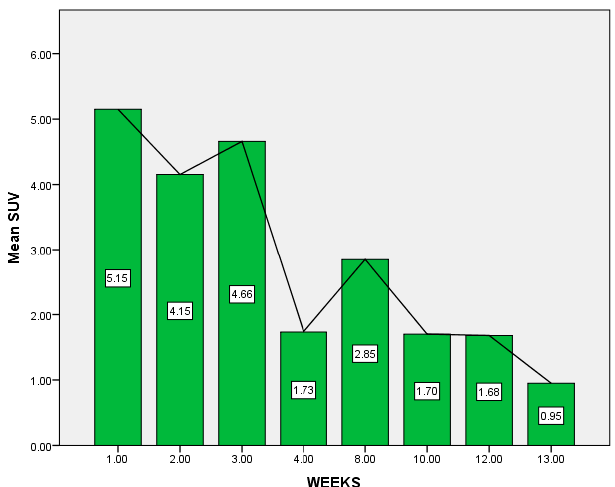
Figure 2. Variation of mean SUVg/mL according to time between vaccination and PET-CT examination in weeks.